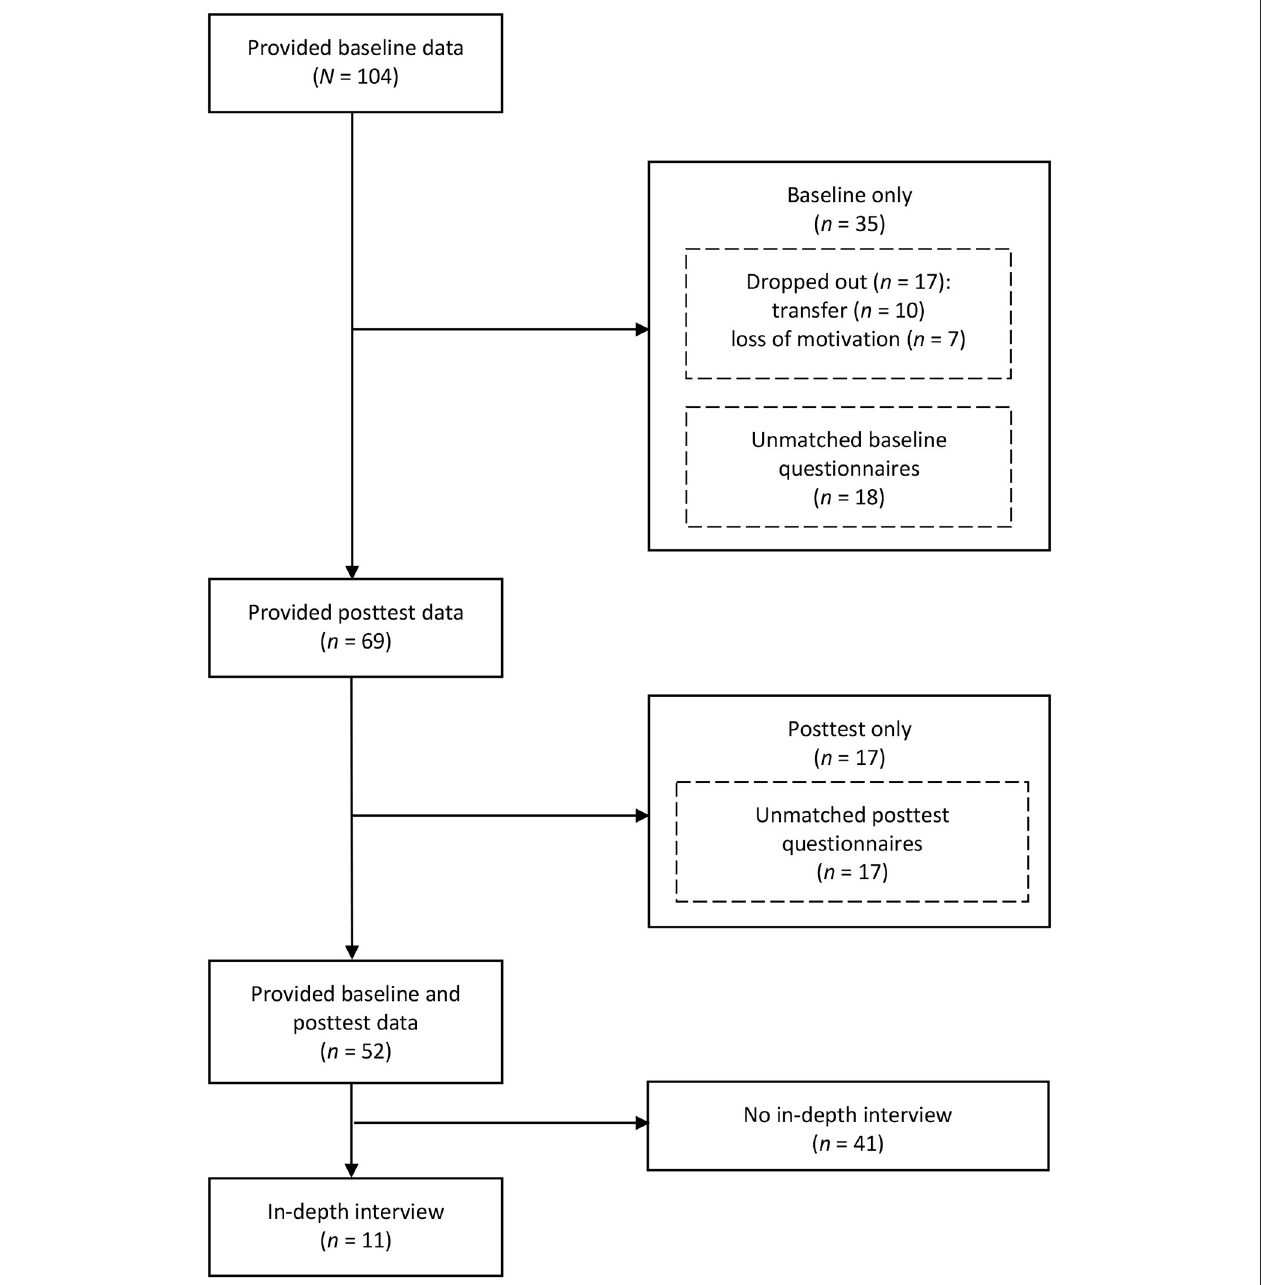
FIGURE 1 | Study flow chart presenting number of respondents at different assessment points.